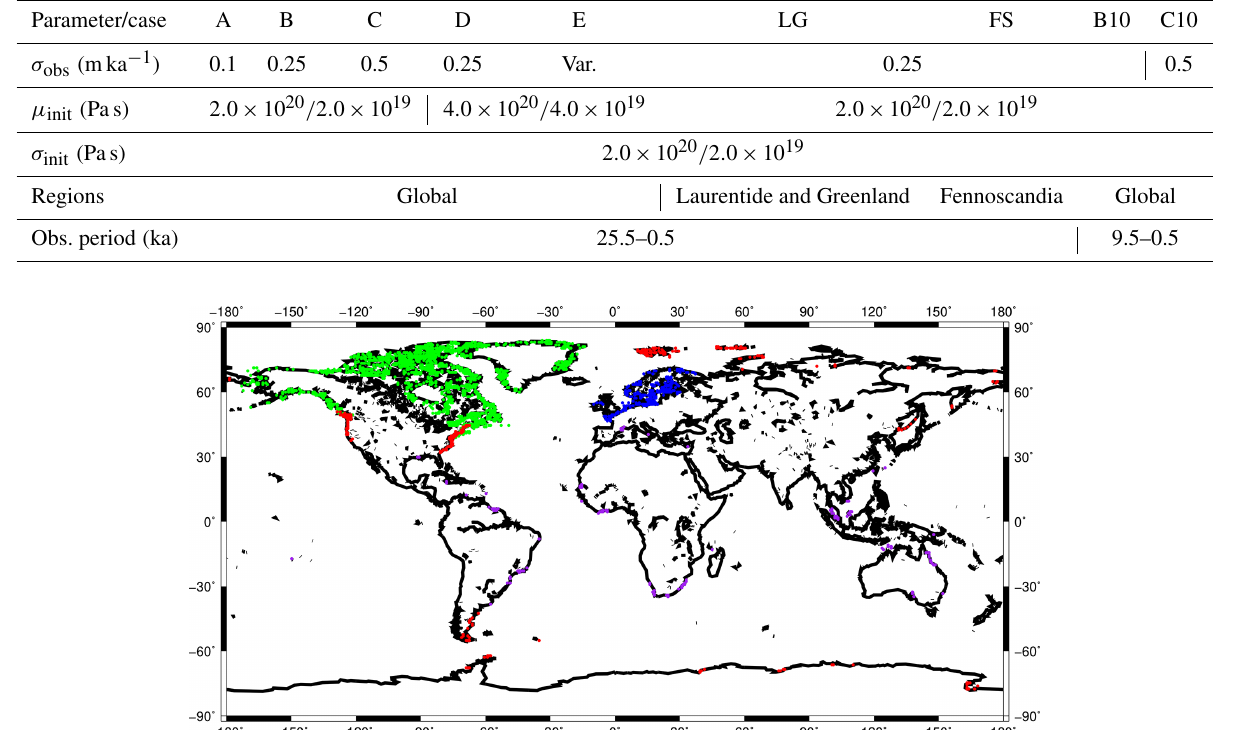
Figure 4. Locations of SLIPs, which are used to generate synthetic observations. The observation locations were sub-divided into the following four regions: Laurentide and Greenland (green), Fennoscandia (blue), far field (purple), and other